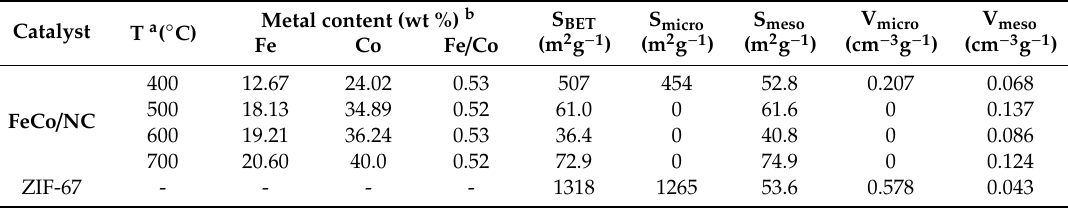
Table 1. The physical properties of the synthesis